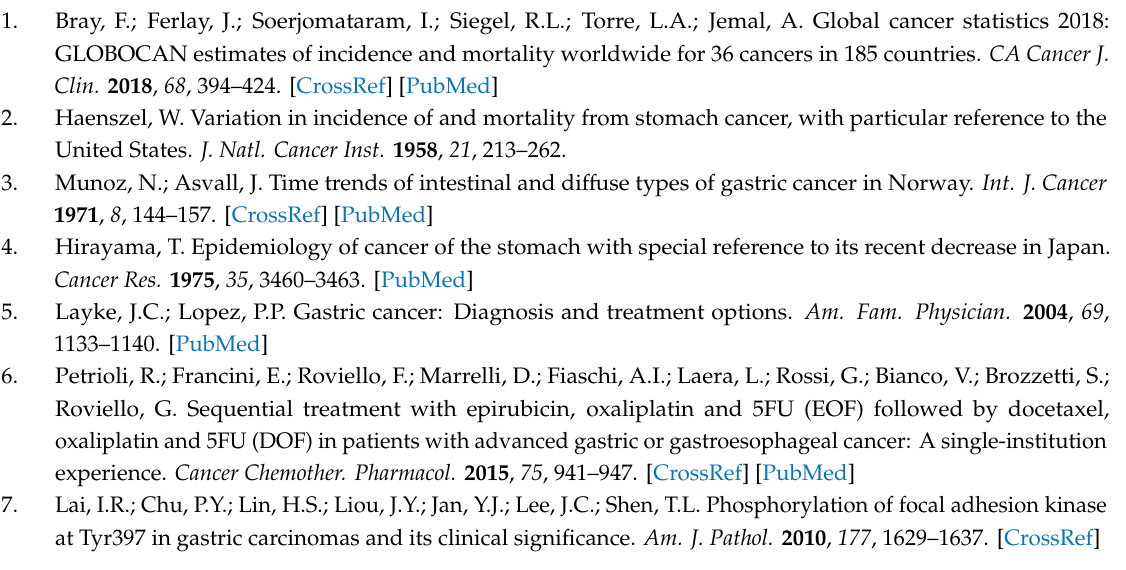
Figure S1:FBXW5 mRNA and protein expressions across gastric cancer cell lines, Figure S2: E ff ect of FBXW5 OE on cell migration and e ff ect of FBXW5 KD on Rac1 activity, Figure S3: E ff ect of FBXW5 OE on FAK signaling and FBXW5 / FBXW7 quantitation, Figure S4: E ff ect of FBXW5 OE on tumor growth and FBXW5 protein expression in luciferase-tagged MKN1 cells, Table S1: Sequence of primers for real-time PCR, Table S2: List of primary and secondary antibodies for Western